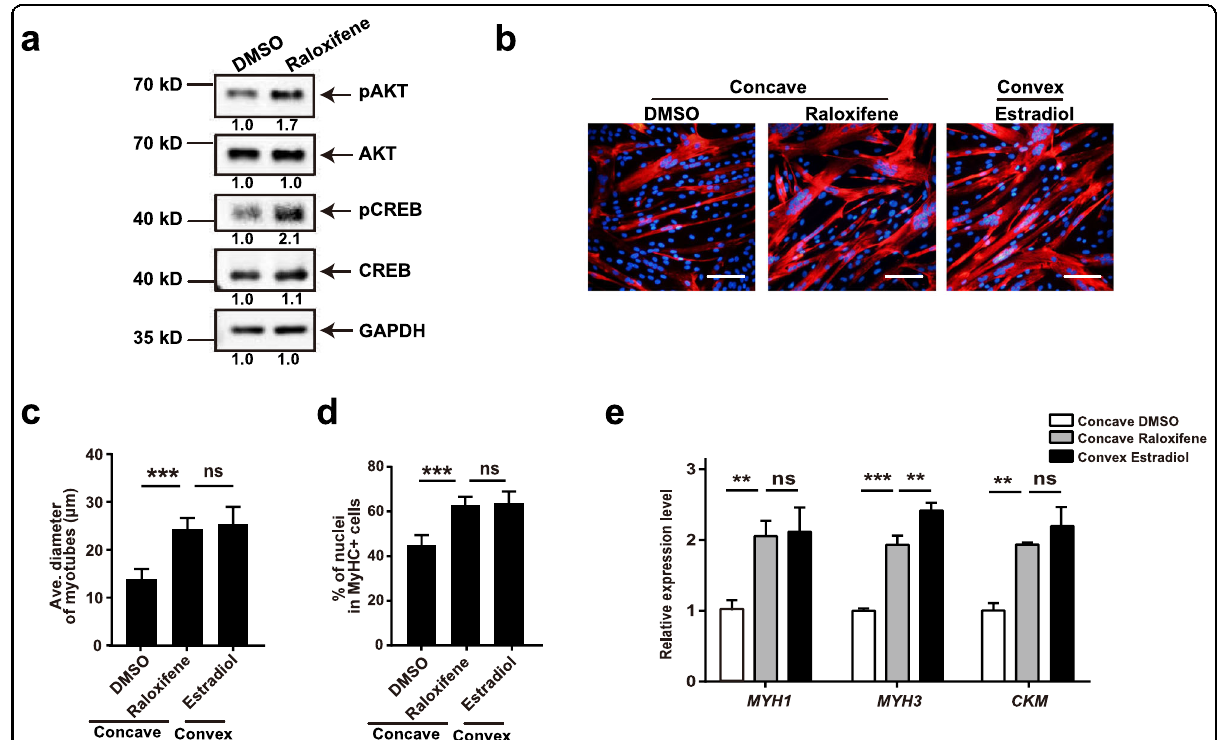
Fig. 5 Raloxifene activates ESR1-AKT-CREB-MYH signaling and rescues the differentiation defects of concave muscle stem/progenitor cells. a Representative immunoblotting of AKT, phosphorylated AKT, CREB, and phosphorylated CREB of human muscle stem/progenitor cells. Upon initiation of differentiation, DMSO or Raloxifene was added in culture for 2 h. Then total proteins were extracted and subjected for immunoblotting. GAPDH served as an internal control. The quanti fi cation of the band intensity was listed below each band. b Representative immuno fl uorescent staining of human muscle stem/progenitor cells treated with Raloxifene. Human muscle stem/progenitor cells were isolated from either the convex or concave side of AIS patients. The cells isolated from the concave side (treated by DMSO or Raloxifene) and convex side (treated by estradiol) were differentiated for 6 days and subjected for MyHC immuno fl uorescent staining. Red indicated MyHC; blue indicated DAPI staining of nuclei. The merged images were shown. Scale bars: 100 μ m. c The statistical analysis of the average diameter of myotubes differentiated from bilateral muscle stem/progenitor cells in AIS with different treatments. Error bars indicated standard deviation ( n = 5). *** P < 0.001; ns indicated no signi fi cant changes. d The statistical analysis of the differentiation ef fi ciency after different treatments. Error bars indicated standard deviation ( n = 5). *** P < 0.001; ns indicated no signi fi cant changes. e The mRNA level of MYH1 , MYH3 , and CKM in myotubes with different treatments. Human muscle stem/progenitor cells isolated from the concave side (treated by DMSO or Raloxifene) and convex side (treated by estradiol) were differentiated for 6 days. Total RNA was extracted and subjected for RT-qPCR analysis. Error bars indicated standard deviation ( n = 3). ** P < 0.01, *** P < 0.001; ns indicated no signi fi cant